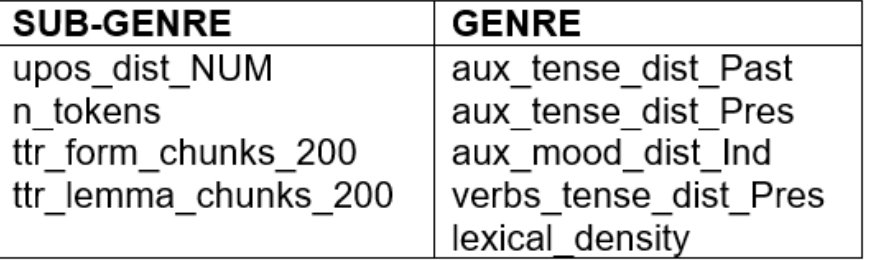
Figure 4. SFS optimal features of each feature set.